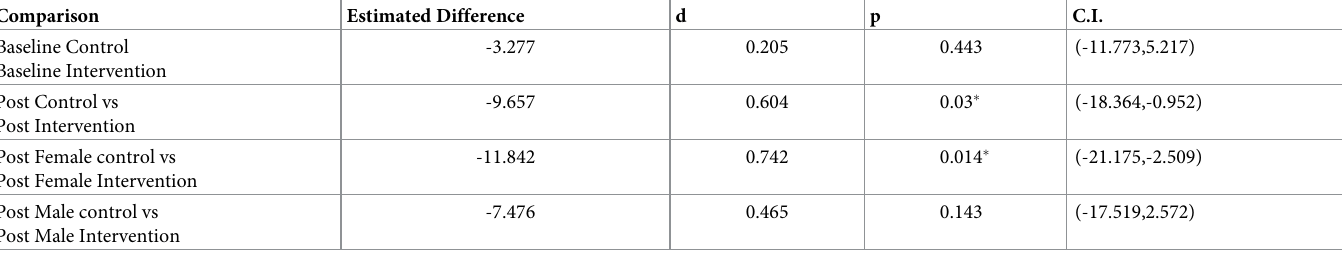
Table 5. Post hoc contrast test analysis for significant interaction